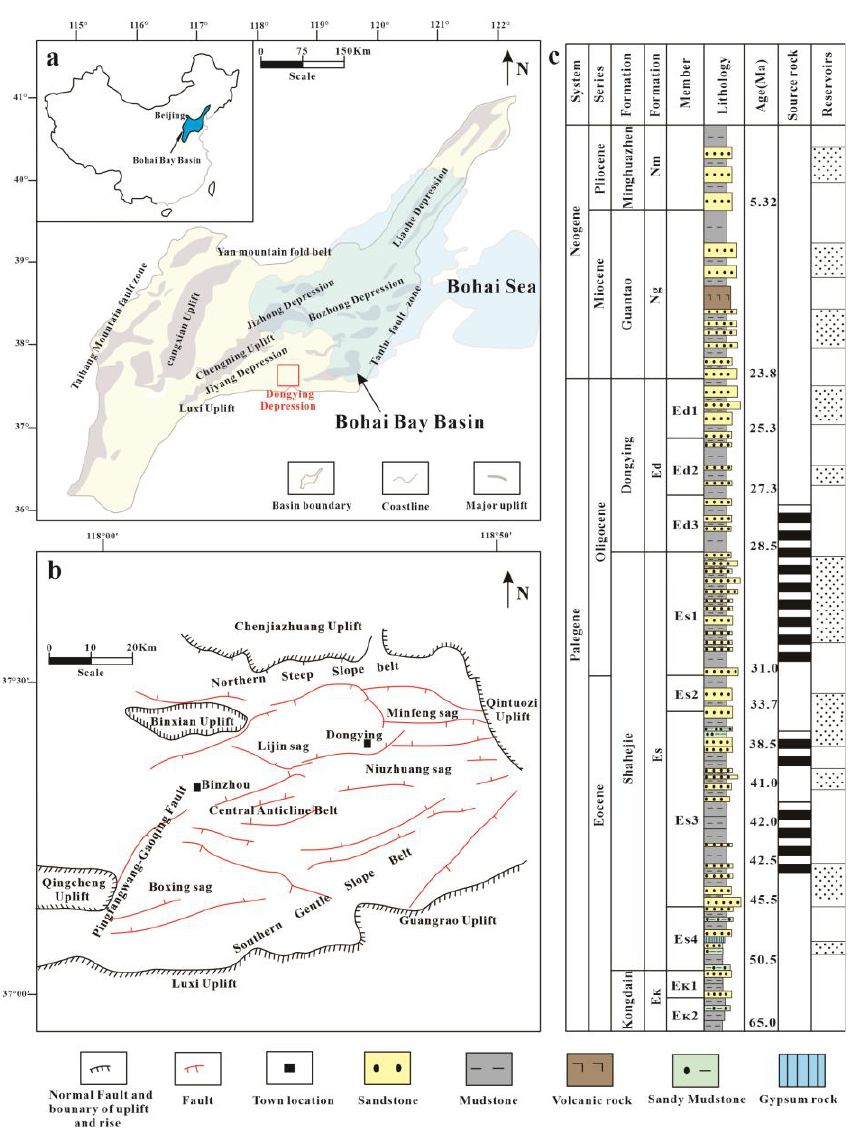
(Figure 1a): the Jizhong depression, Huanghua depression, Bozhong depression, Liaohe depression, Jiyang depression, and Linqing depression [28].